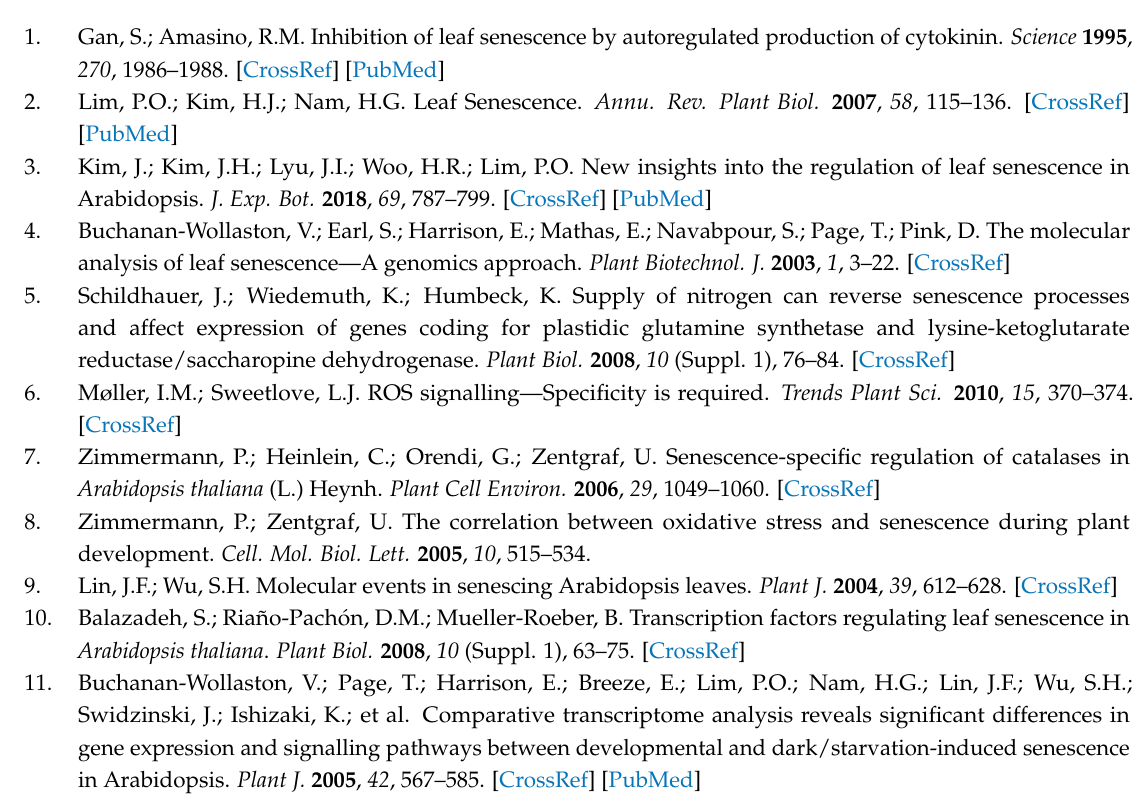
Figure S1: Measurement of different parameters over the development of Col-0, 35S:ERF4-R, 35S:ERF4-A and erf4 mutant plant lines. Figure S2: Relative expression level of senescence-related genes. Figure S3: Isoform specific semi-quantitative RT-PCR. Figure S4: Isoform specific semi-quantitative RT-PCR of the complementation lines. Figure S5: CATALASE protein amounts and enzyme activity in 5- to 8- week-old Col-0 and erf4 mutant plants. Figure S6: ERF4-A and ERF4-R protein expression in Arabidopsis protoplasts. Figure S7: Protein–Protein interactions in transiently transformed protoplasts. Figure S8: Protein alignment of the first 122 amino acids (AA) of A. thaliana and N. tabacum ERF4. Table S1: Primer